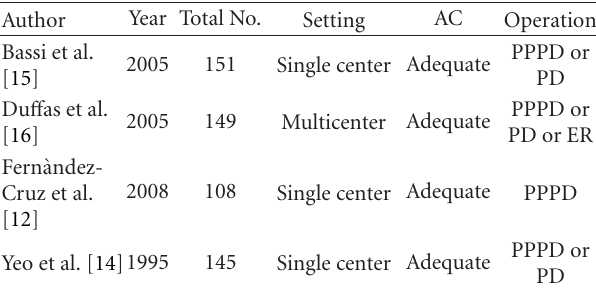
Table 1: Characteristics of RCTs Included in the